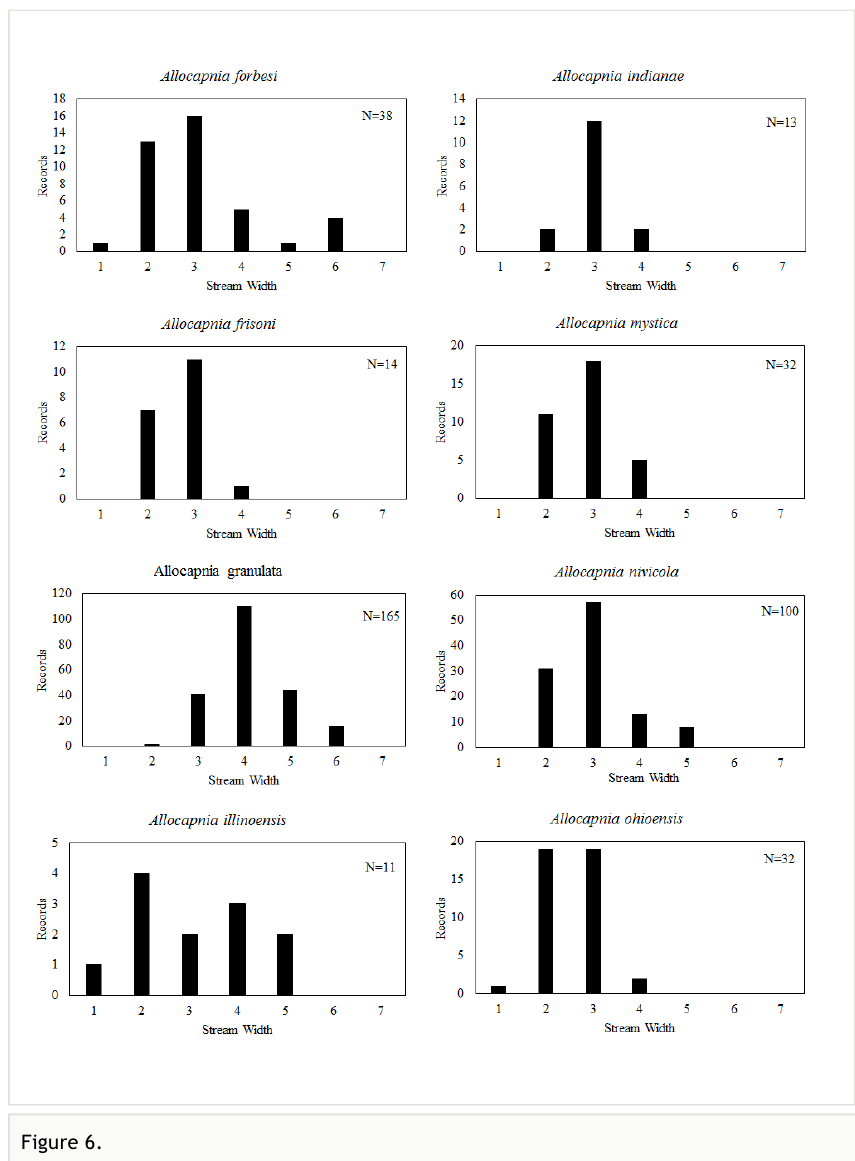
Stream width categories occupied by Capniidae species in Ohio.